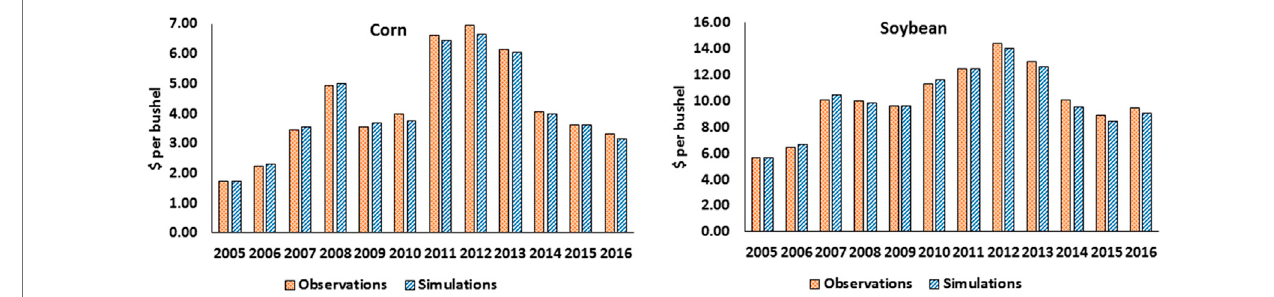
FIGURE 7 | Observed and simulated market results for corn and soybean nominal prices 2005 – 16.